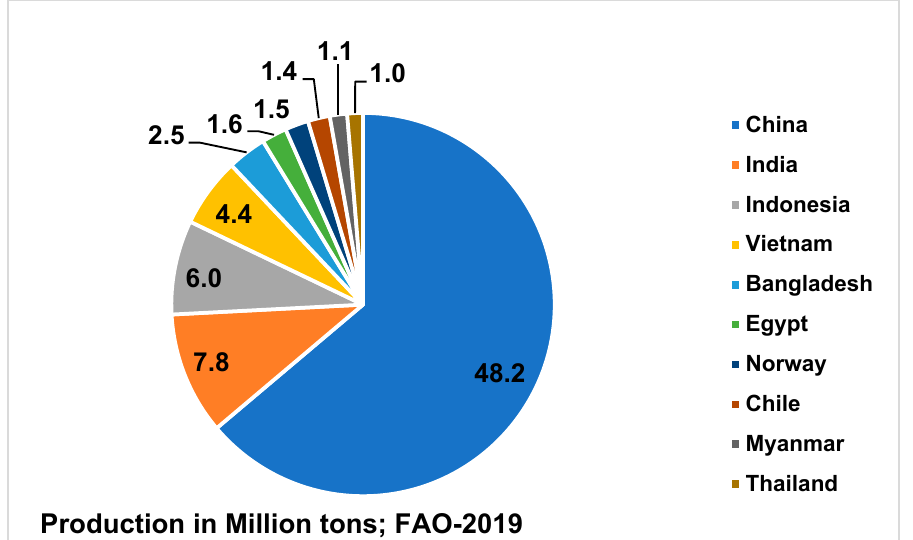
Figure 1. Global Aquaculture Production.